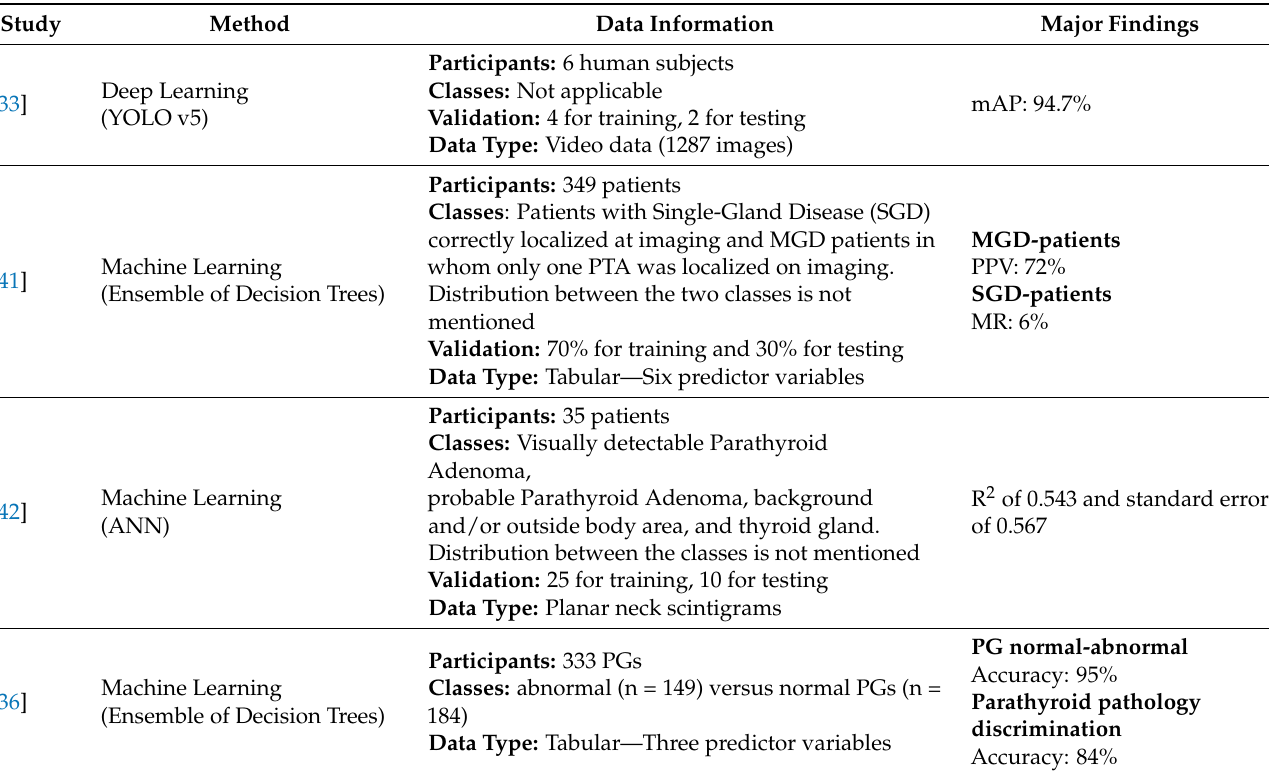
Table 2. Key findings and experiment information of the presented